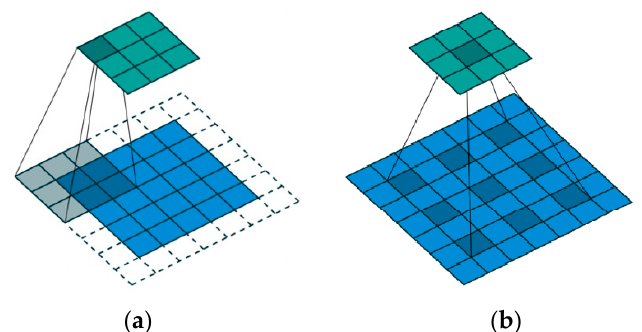
Figure 7. 3 ×3 convolutional kernels with dilation rates of 1 and 2 [39] : ( a ) dilated convolution with Figure 7. 3 × 3 convolutional kernels with dilation rates of 1 and 2 [39]: ( a ) dilated convolution with dilation rate r = 1 and ( b ) dilated convolution with dilation rate r = dilation rate r = 1 and ( b ) dilated convolution with dilation rate r =2.